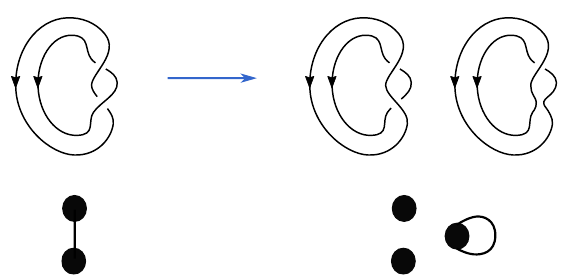
Figure 1. Multi-cover skein relations on linking disks and dual quiver